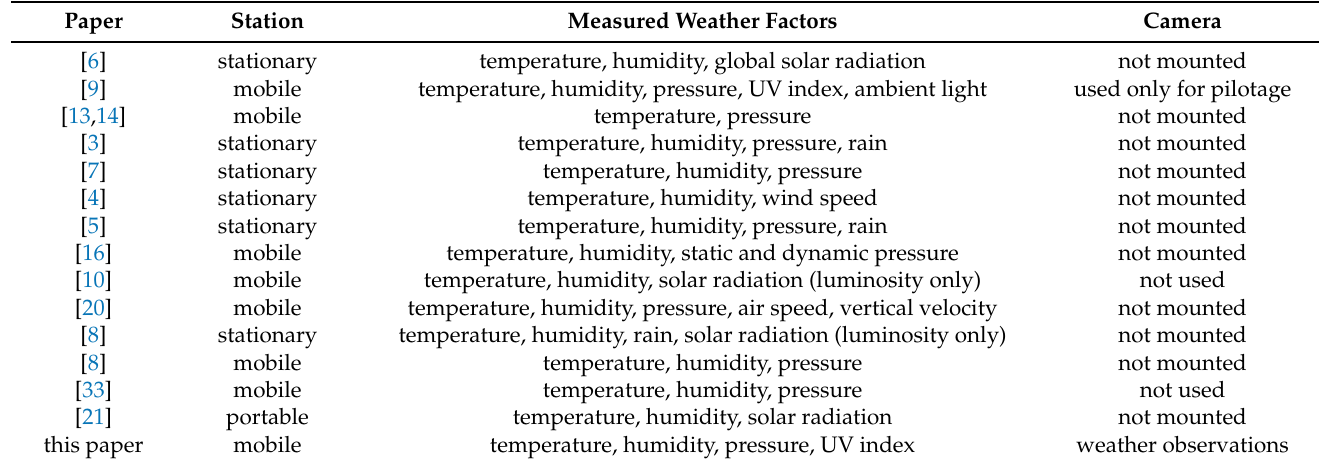
Table 1. Measured weather